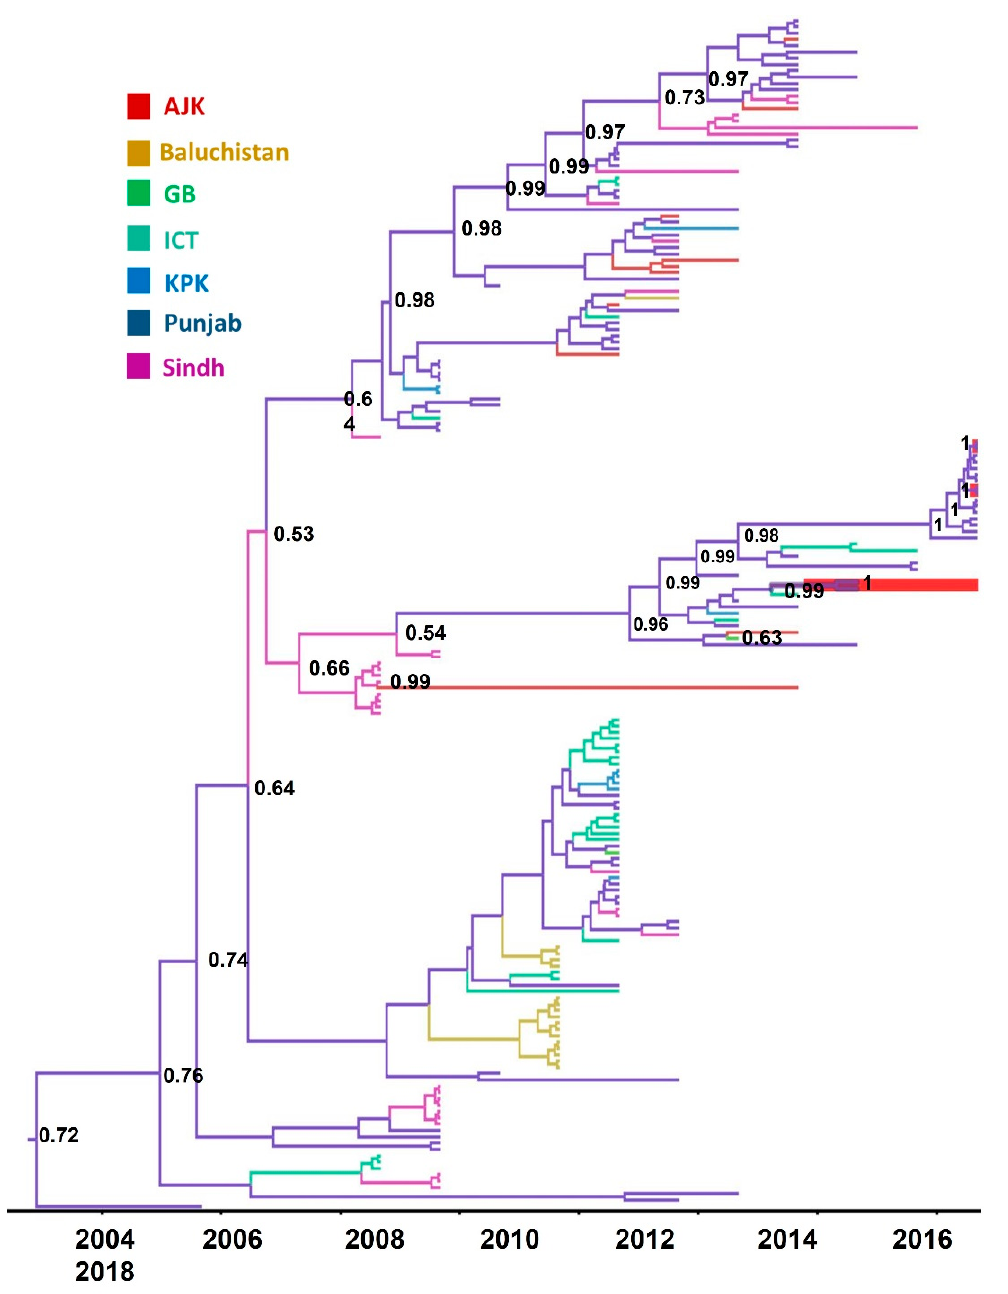
Figure 4. Reconstruction of phylogeographic diffusion of FMDV serotype A viruses from Pakistan. In total, 189 spatially and temporally stamped VP1 sequences were included in this analysis. The spatial dispersal of viruses in a discrete space was reconstructed to estimate the ancestral locations. The branches and nodes in the time-calibrated MCC tree are colored for locations and represent transmission history. The nodes are colored for ancestral locations and annotated with ancestral location probability. Taxa highlighted in red were sequenced in this